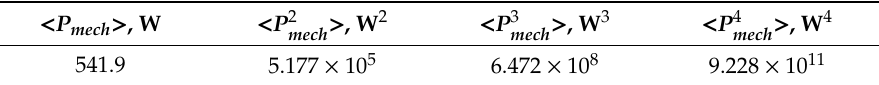
Table 2. The average values of the powers of the mechanical power.